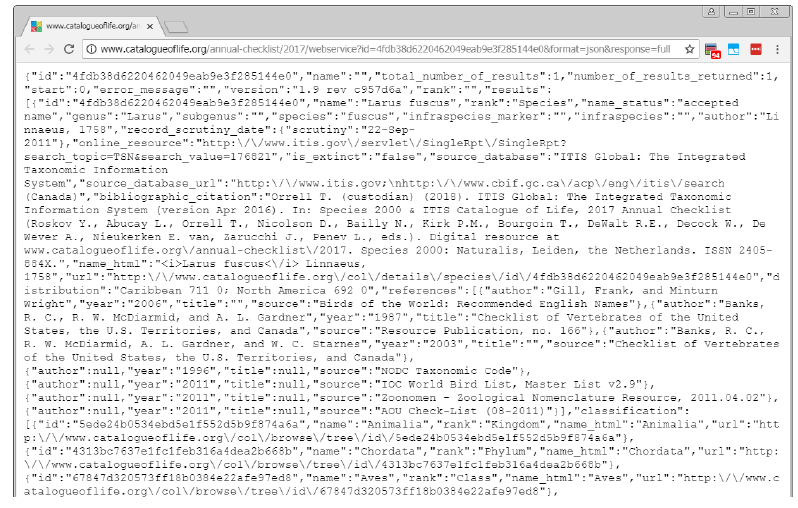
Figure 6 – A JSON data feed from the Catalogue of